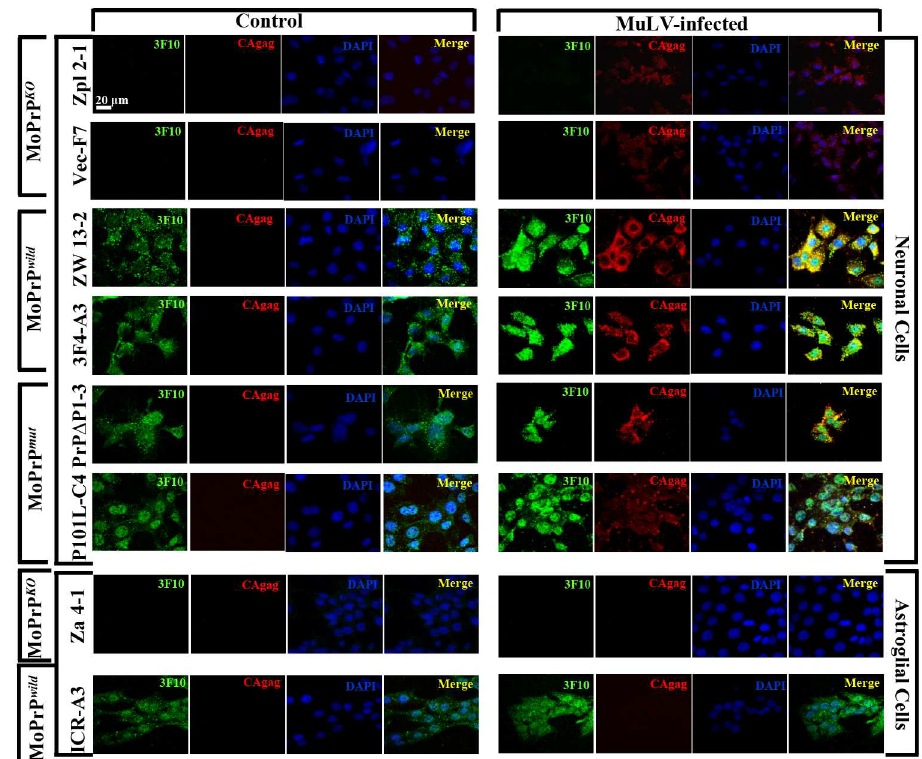
Fig 3. Different susceptibility to MuLV infection of MoPrP KO , MoPrP wild and MoPrP mut neuronal cells. Neuronal cells expressingPrP C , regardlessof their type, were shown to have highersusceptibility to MuLV infectionin illuminationmicroscopy. Neuronal cells expressingMoPrP wild , ZW, or PrP C with the 3F4 epitope, or MoPrP mut with the octarepeat deletion,PrP Δ , showedintense stainingof both PrP and CAgagat a similar level. The location of PrP in these cells was primarily in cytosol and membranebefore MuLV infection. After MuLV infection, PrP stainingwas observed in the nucleus, cytosol, and also membranes. MuLV infectionwas observedmainly in cytosol by detectionof CAgag. Neuronal cells expressingP101L mutant type of PrP C , MoPrP mut , were also susceptible to MuLV infection. The PrP C of P101L was mainly located in the nuclear portion of the cells, thus the overlappingbetweenPrP C and CAgag was not observed clearly through illumination microscopy. MuLV infectionsin astroglialcells were not affected by PrP C . Different from neuronal cells, astroglialcells were largely resistant to infection by MuLV. Green, PrP; Red, CAgag; Blue, DAPI; Yellow, Merge. Scale bar = 20 μ